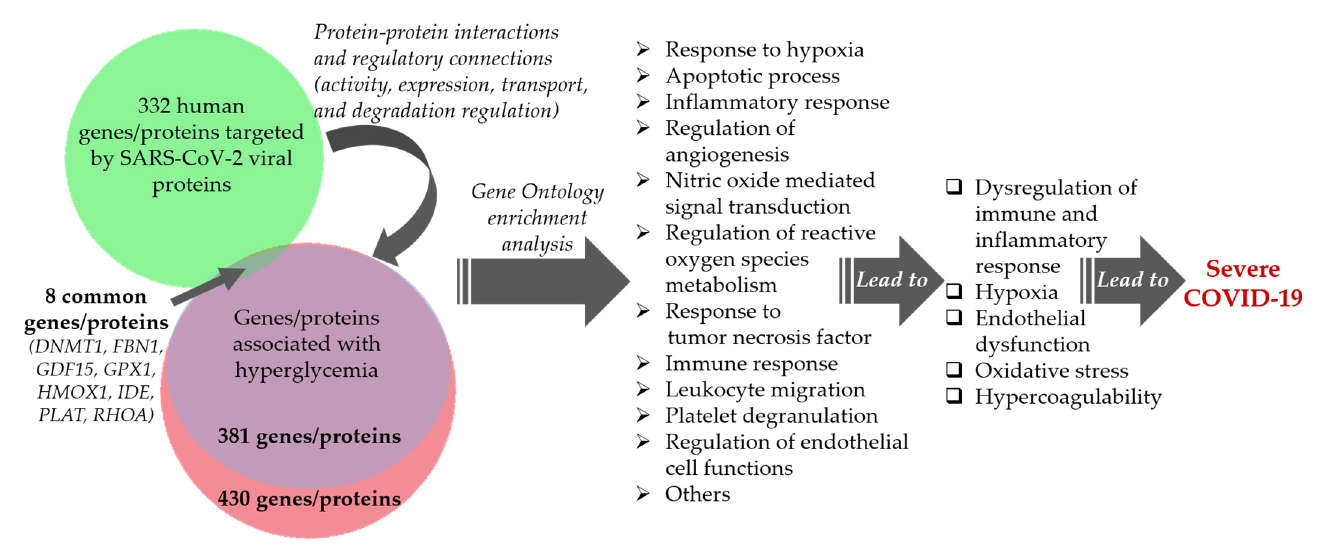
Figure 11. Interactions between hyperglycemia-associated network and network of SARS-CoV-2- targeted proteins contribute to severe COVID-19 in patients with diabetes.